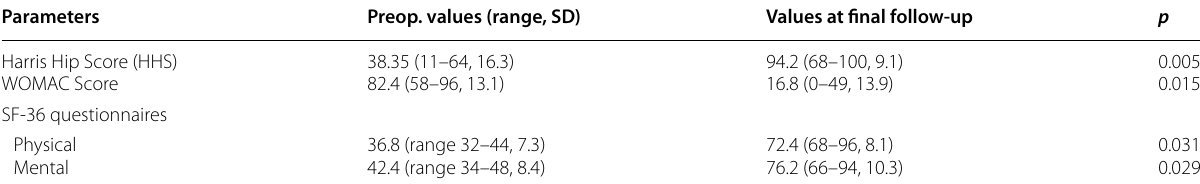
Table 3 Comparison of the clinical and radiographic results between preoperative and postoperative values Parameters